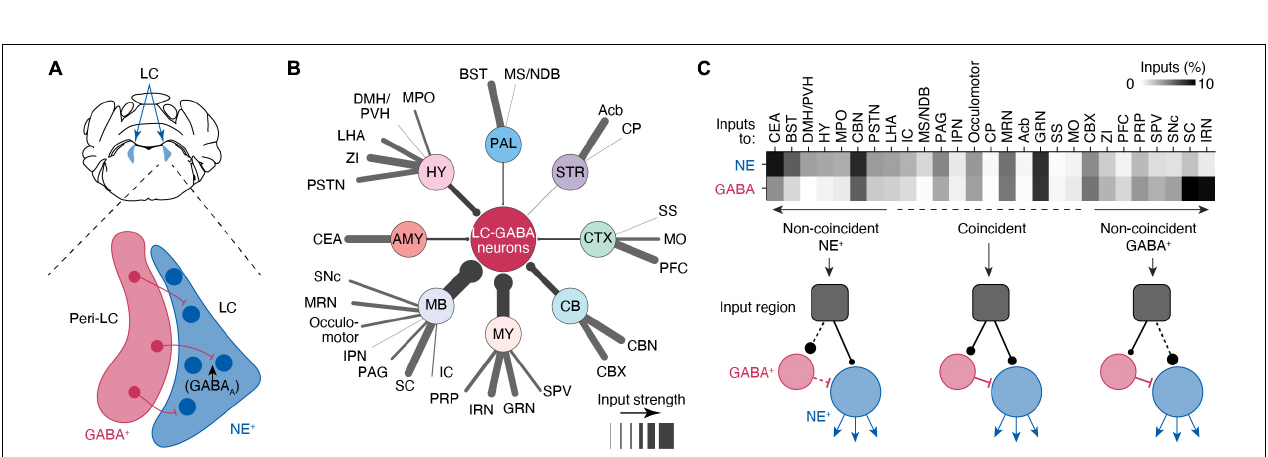
FIGURE 1 | Anatomy of the LC-NE system. (A) Anatomy of the outputs originating from the LC nucleus in human and mouse. Shaded areas indicate major sub-regions that potentially send input to LC. In this illustration, we have assumed that input regions identified in mouse are similar in humans (B) Distal inputs to LC-NE neurons obtained by retrograde tracing using rabies virus targeted at LC-NE neurons in mice. Input regions are grouped by: cortex (CTX), striatum (STR), pallidum (PAL), hypothalamus (HY), amygdala (AMY), midbrain (MB), medulla (MY), and cerebellum (CB). The thickness of each line represents the strength of the input from each region. Input strength was calculated by counting the number of cells retrogradely labeled in a specific area and dividing it by the total number of retrogradely labeled neurons. Regions providing less than 0.5% of inputs were left out of this diagram. Local inputs from the pons were also excluded. PFC, prefrontal cortex; MO, motor area; SS, somatosensory area; Acb, nucleus accumbens; CP, caudoputamen; BST, bed nucleus of stria terminalis; MS/NDB, medial septal/diagonal band nucleus; MPO, medial preoptic area; DMH/PVH, dorsomedial/paraventricular nucleus; LHA, lateral hypothalamic area; ZI, zona incerta; PSTN, parasubthalamic nucleus; CEA, central amygdala; SNc, substantia nigra; MRN, midbrain reticular nucleus; IPN, interpeduncular nucleus; PAG, periaqueductal gray; SC, superior colliculus; IC, inferior colliculus; PRP, nucleus prepositus; IRN, intermediate reticular nucleus; GRN, gigantocellular reticular nucleus; SPV, spinal nucleus of the trigeminal; CBX, cerebellar cortex; and CBN, cerebellar nuclei. Data in (B) from Breton-Provencher and Sur (2019).